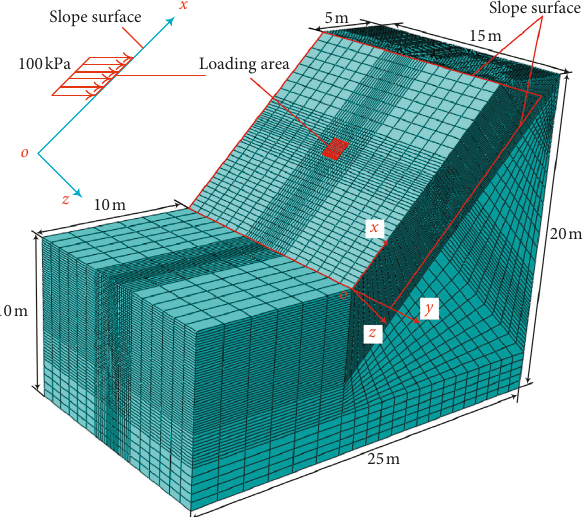
Figure 14: Finite element mesh of the PE.